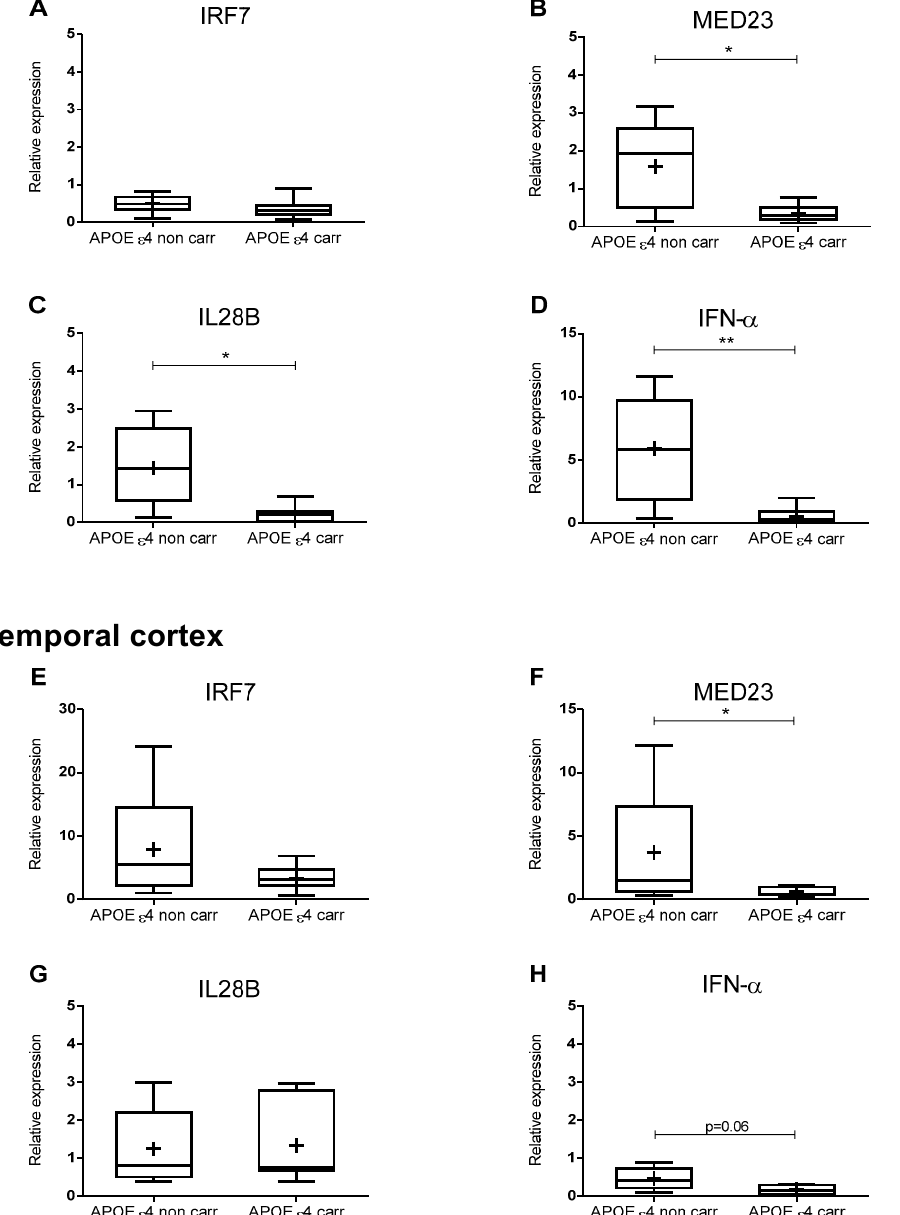
Figure 2. E ff ect of APOE ε 4 allele on antiviral immune gene expression of AD patients. q-PCR data showing relative expression (2 - ∆ Ct values using CYC1 and EIF4A2 as reference genes) of IRF7 ( A , E ), MED23 ( B , F ), IL28B ( C , G ), IFN- α ( D , H ) in hippocampus ( A – D ) and temporal cortex ( E – H ) of AD patients grouped in APOE ε 4 noncarrier / or APOE ε 4 carrier. Data from each group are shown as a box and whiskers plot with the ends of the whiskers represent the minimum and maximum data values, the horizontal line represents the median, and the “ + ” represents the mean relative expression values. * p < 0.05 ** p < 0.01 (unpaired